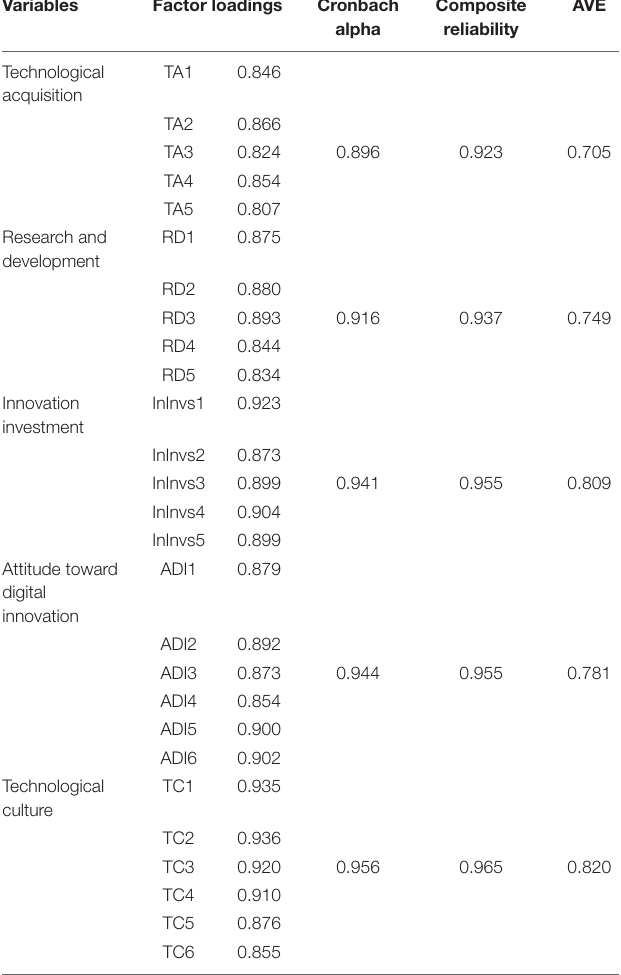
TABLE 2 | Factor loadings, Cronbach Alpha, composite reliability, and average variance extracted (AVE).